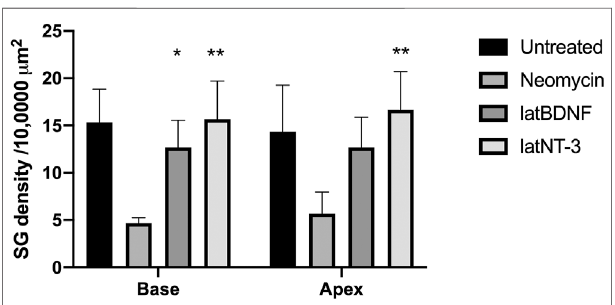
FIGURE 6 | Neuronal survival after neomycin treatment and after neomycin treatment followed by delivery of Ad28.lat.bdnf or Ad28. lat.ntf3. Delivery of BDNF resulted in statistically signi fi cant improvement of spiral ganglion survival in the basal turn. NT-3 delivery signi fi cantly improved spiral ganglion survival in both the basal and apical turns. Error bars represent standard deviation ( n = 3).